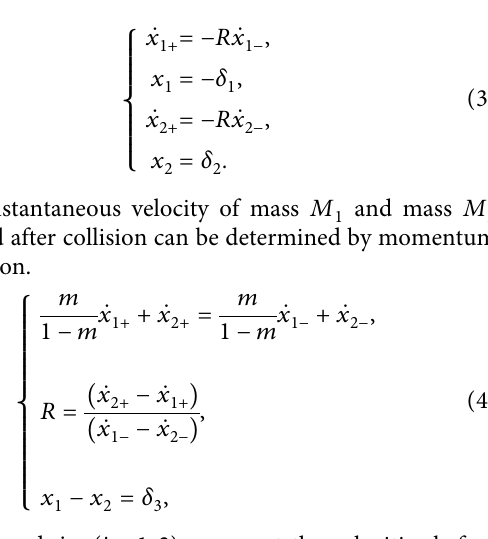
Figure 1: Physical model of a two-degree-of-freedom periodically forced system with multiple rigid